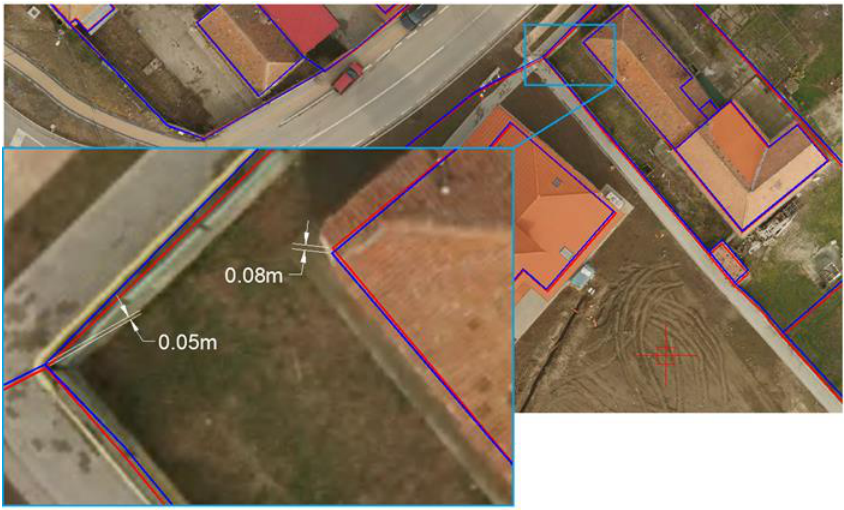
Figure 15. Comparison of the recorded boundaries using the proposed procedure (in blue) with those obtained from the official Cadastral Maps.